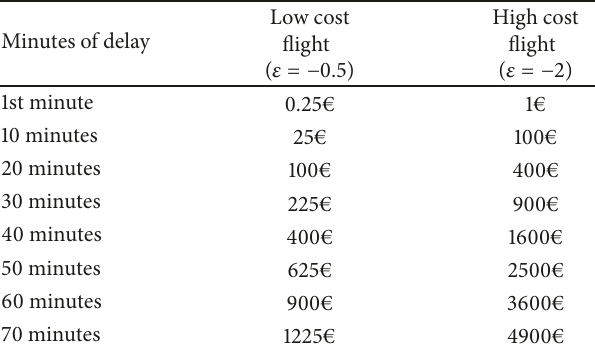
Table 2: Distribution of flights and delay per AU. Minutes of